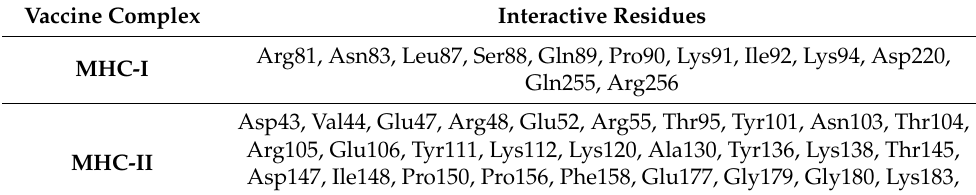
Table 3. The interacting residues of the receptors with the vaccine molecule. Vaccine